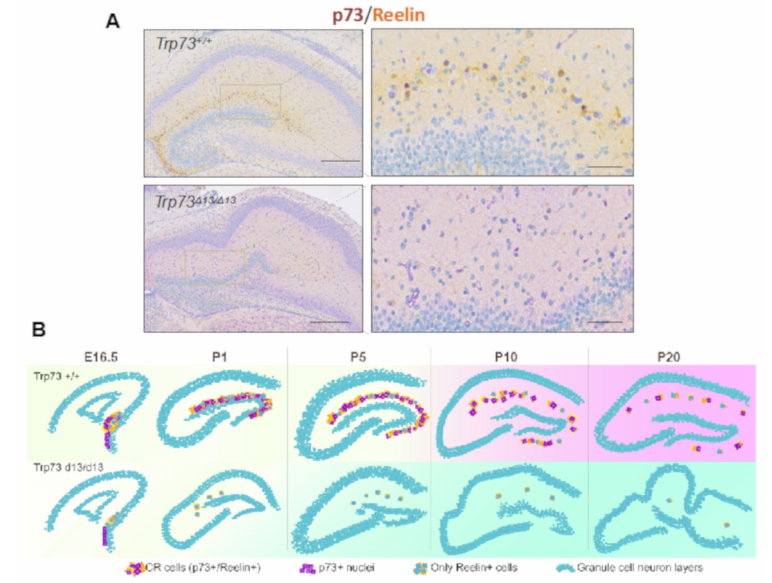
Figure 3. Trp73 D13 / D13 mice display hippocampal dysgenesis and CR cells depletion. ( A ) Immunohistochemistry of postnatal day 5 (P5) mouse hippocampus displays disrupted morphology and reduced presence of Reelin + CR cells in Trp73 D13 / D13 genotype. Scale bars indicate 500 µ m and 50 m. ( B ) Representative summary of morphological developmental progression in the hippocampus of Trp73 +/+ and Trp73 D13 / D13 from embryonic 16.5 (E16.5) to postnatal day 20 (P20) stage. Adapted with modifications from Amelio et al.